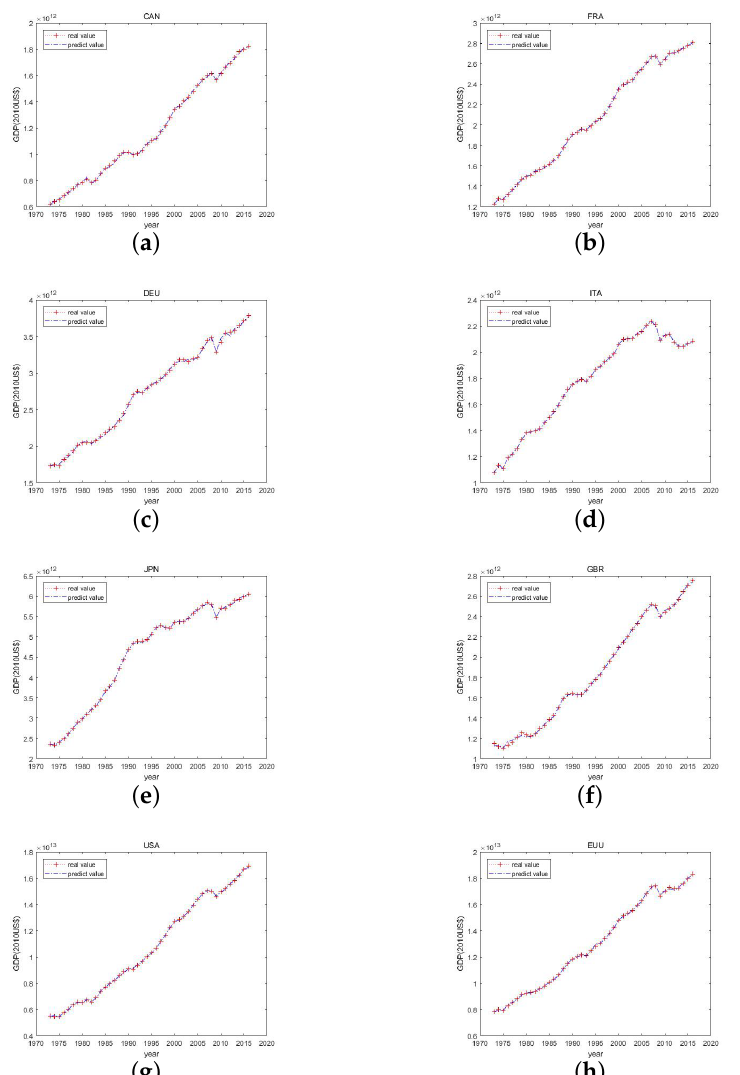
Figure 3. Fitting results for the BP neural network model for the G7 countries: ( a ) Canada ( b ) France ( c ) Germany ( d ) Italy ( e ) Japan ( f ) the United Kingdom ( g ) the United States ( h ) European